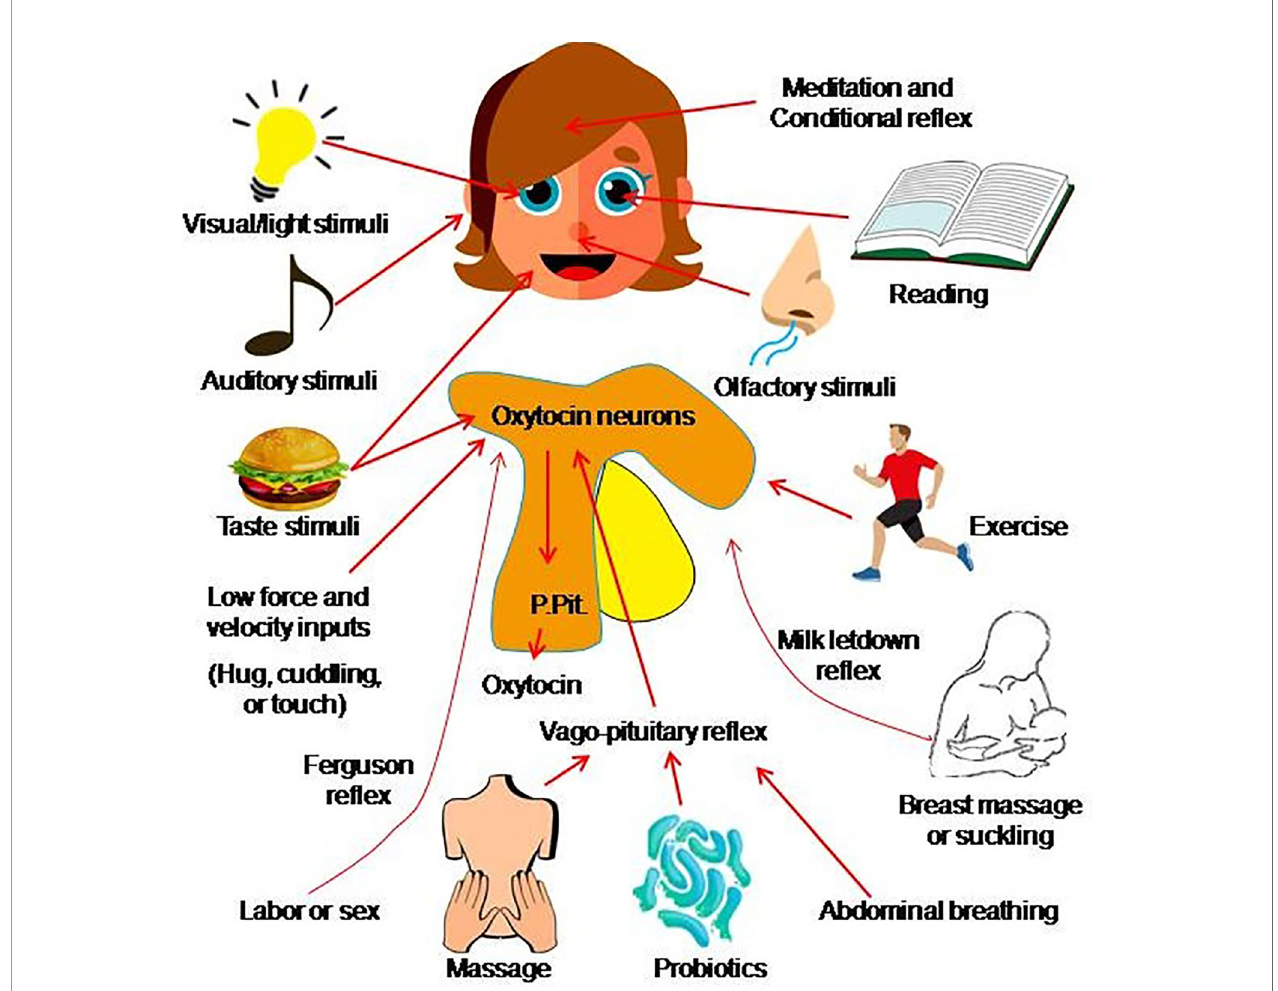
FIGURE 2 | Approach of mobilizing endogenous oxytocin. Oxytocin secretion from the posterior pituitary gland (P.Pit) can be evoked by a variety of stimuli that activate oxytocin neurons in the hypothalamus and involve several pathways such as the sex-/labor-associated Ferguson re fl ex, the breastfeeding-associated let- down re fl ex (also called the milk-ejection re fl ex), the vago-pituitary re fl ex, as well as a conditioned re fl ex (acquired as the result of experience) and many other stimuli. The mechanisms underlying pathways from the stimulus to oxytocin secretion largely remain to be identi fi ed (the fi gure is an original